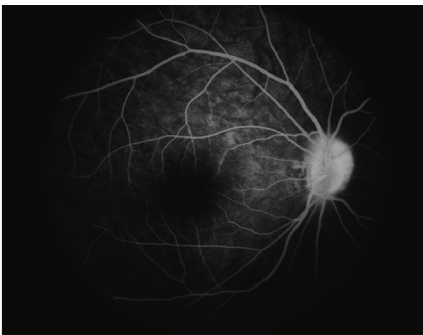
Figure 2: FFA of a patient with ODD. FFA reveals a slightly blurred optic disc boundary. No obvious fluorescence leakage was observed during the prolongation of imaging time. However, in the late stage, light fluorescence staining was noted at the edge of the local optic disc.